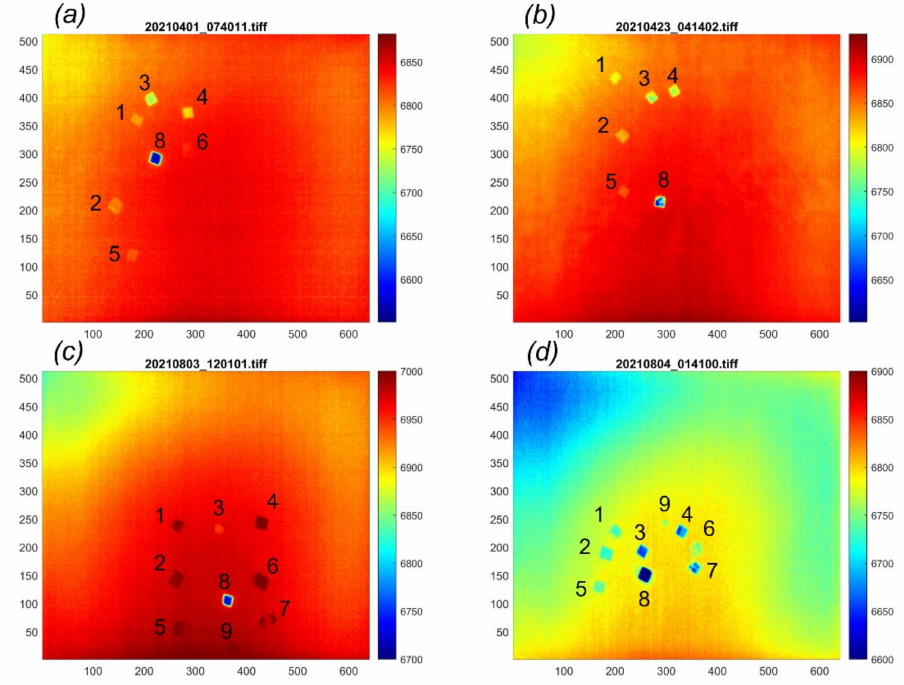
Figure A2. Images taken during the four surveys with the FLIR camera, ( a ) 1 April, ( b ) 23 April ( c ) 3 August, ( d ) 4 August; the pseudo color scale indicates DN. Numbers as in Figure